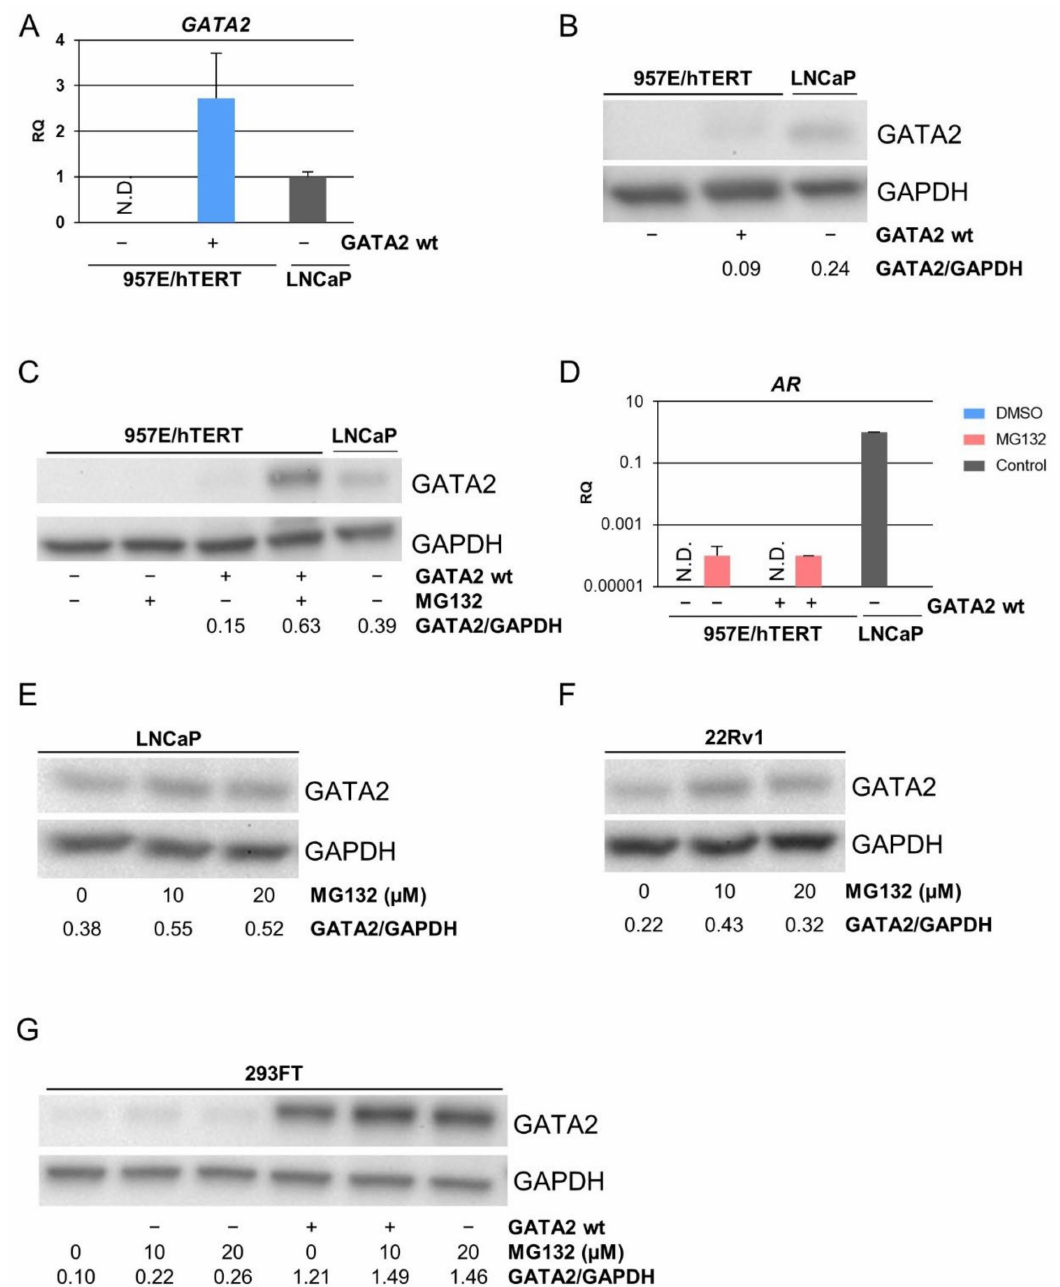
Figure 1. Exogenous expression of GATA2 in basal-like TA cells and GATA2 degradation. ( A ) RT- qPCR and ( B ) Western blot of exogenous GATA2 in 957E/hTERT cells and endogenous GATA2 in LNCaP cells. ( C ) Cells stably expressing GATA2 and control cells treated with DMSO or 10 µ M MG132 for 8 h. ( D ) RT-qPCR of 957E/hTERT-GATA2 and control cells treated with 20 µ M MG132 for 8 h. ( E ) Western blot of LNCaP and ( F ) 22Rv1 cells treated with indicated concentrations of MG132 for 8 h. ( G ) Western blot of 293FT cells stably expressing exogenous GATA2 or control, and treated with indicated concentrations of MG132 for 8 h. Error bars display 95% confidence intervals. N.D. = not